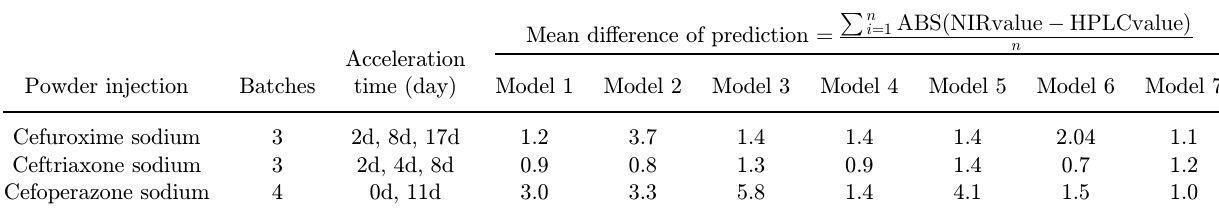
Table 4. Prediction results of di®erent models for accelerated degradation